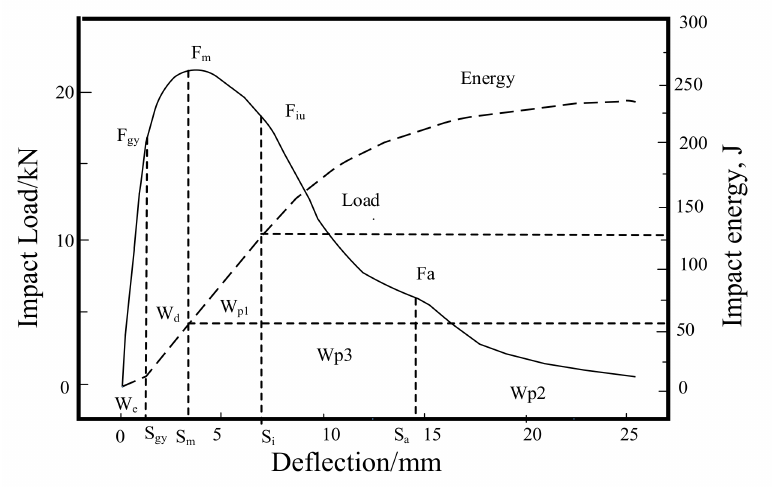
Figure 11. Load-deflection (energy) curves of instrumented impact.